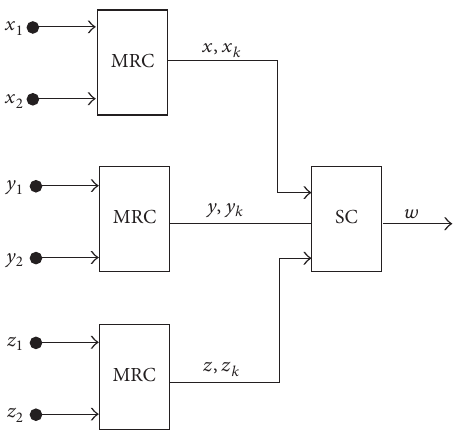
Figure 1: Macrodiversity system with three microdiversity MRC receivers and one macrodiversity SC